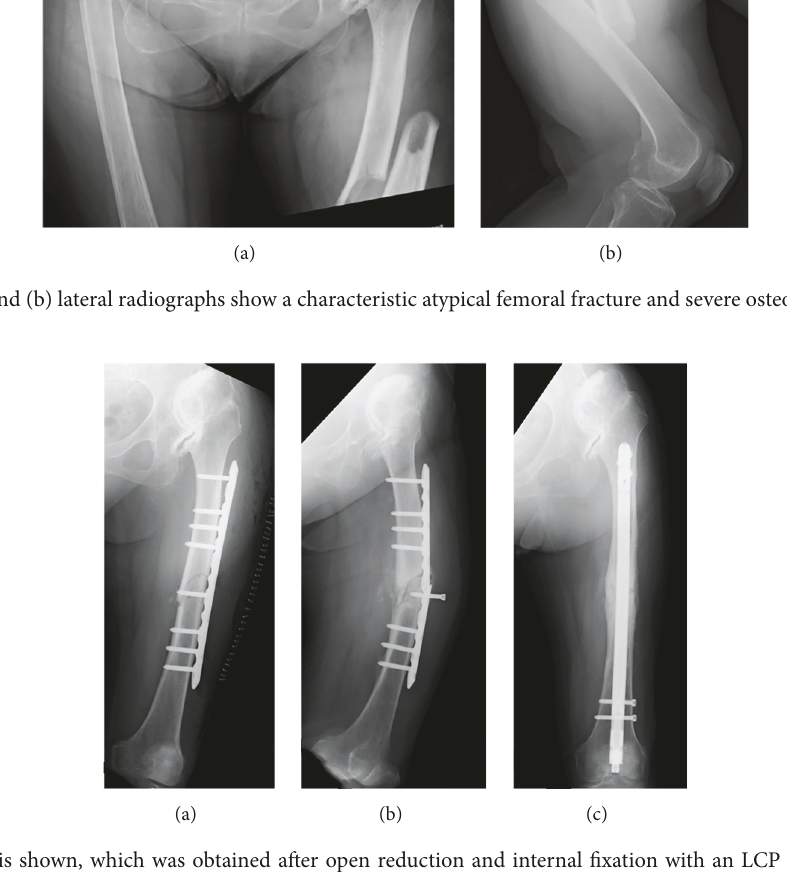
Figure 3: (a) AP image is shown, which was obtained after open reduction and internal fixation with an LCP plate. (b) AP radiographs obtained 22 weeks after fracture surgery show plate breakage. (c) AP image obtained 43 weeks after initial fracture surgery; reoperation was performed with retrograde intramedullary